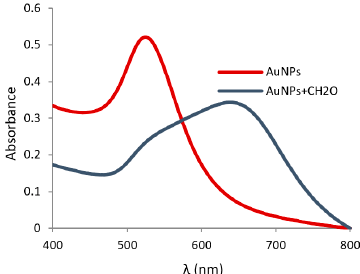
Figure 2. Absorption spectrum of the AuNP-1 in water at room temperature, in the presence and in the absence of excess (50 mM)